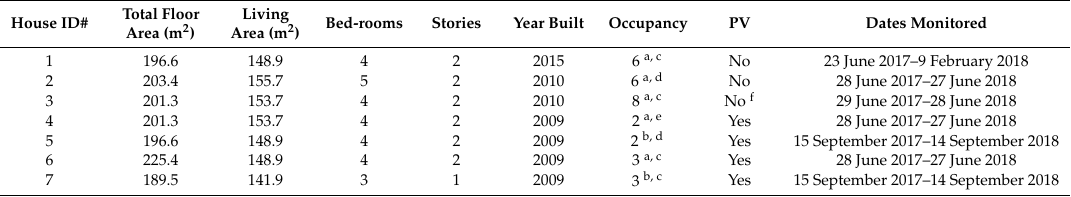
Table 1. Characteristics of the seven houses included in the study and the dates of